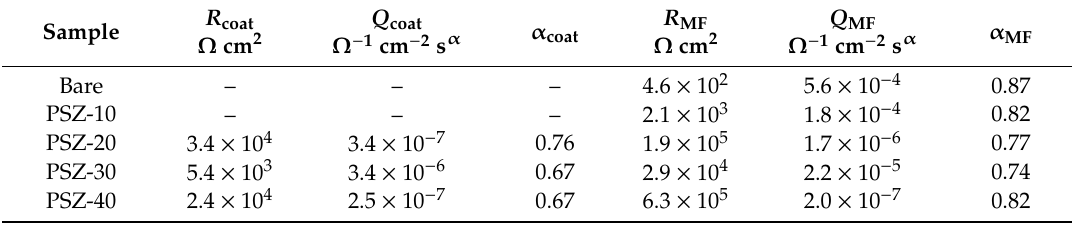
Table 2. Fitting parameters: R coat , Q coat , α coat , R MF , Q MF , and α MF of spectra at 1 h of immersion.